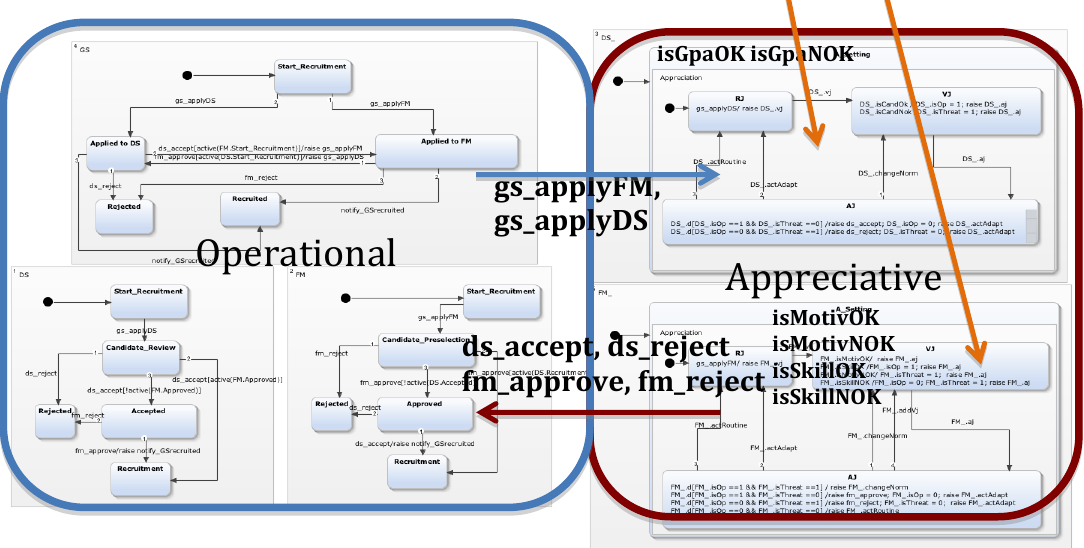
Figure 13. Extended model of the PhD recruitment process. Interactions between the operational model and the appreciative model are illustrated with bold colored arrows showing the corresponding “in” and “out”